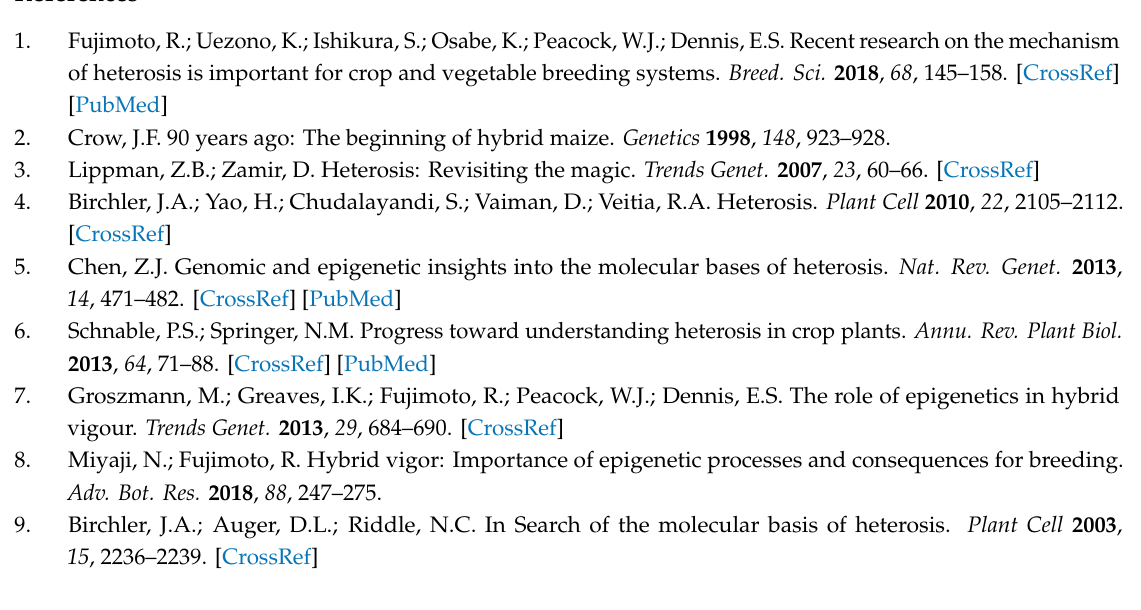
Figure S1: Distribution of rosette diameter at 14 DAS in parental lines and their reciprocal hybrids. Figure S2: Expression pattern of genes upregulated in big-sized F 1 plants compared with medium-sized F 1 plants and downregulated in ddm1 F 1 compared with wild-type F 1 . Figure S3: Plant phenotypes of transgenic plant lines of #9 and #19 at 21 DAS. Figure S4: Confirmation of transgene expression levels by RT-PCR. Table S1: Di ff erentially expressed genes between big- and medium-sized F 1 plants. Table S2: Genes showing di ff erential expression between big- and medium-sized F 1 plants and upregulation in C24 / Col and C24 / L er hybrids. Table S3: Validation of microarray expression data by quantitative RT-PCR. Table S4: Comparison of gene expression levels between big- and medium-sized F 2 plants. Table S5: GO function term overrepresented in genes showing B1&B2 > M1&M2 expression. Table S6: GO function term overrepresented in genes showing B1&B2 < M1&M2 expression. Table S7: GO function term overrepresented in genes showing B1&B2 > M1&M2 expression and upregulation in both C24 / Col and C24 / L er hybrids. Table S8: Sequences of primers used in this